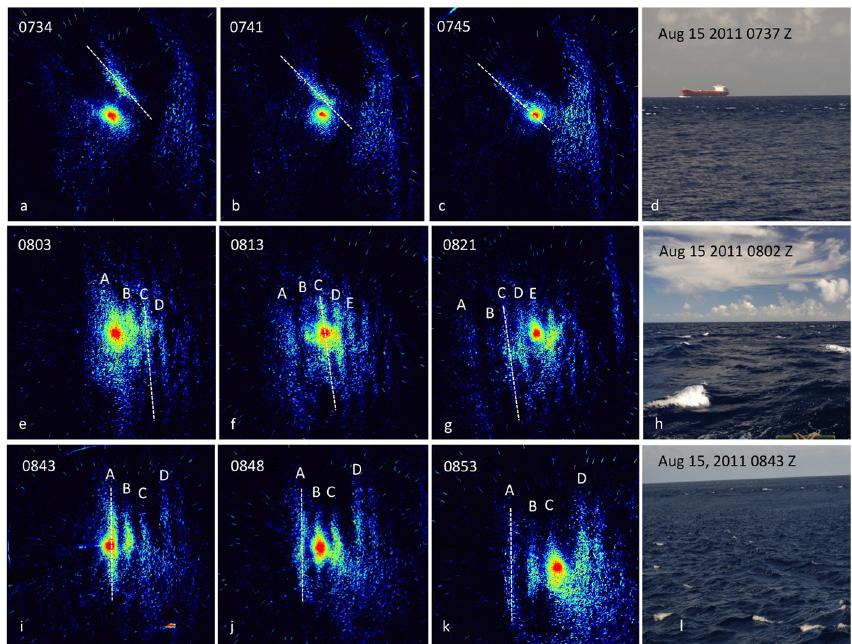
Figure 7. Time series of ship’s radar images and sea surface photographs corresponding to the three events highlighted in Fig. 6. The top panels show the solitary wave, the middle panels Packet 1, and the bottom panels Packet 2. Table 1. Summary of mode-2 wave